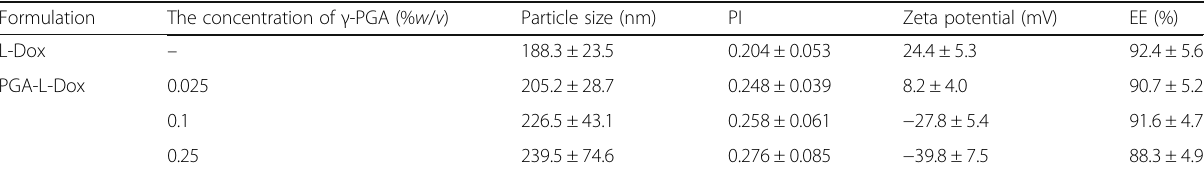
Table 1 Physicochemical properties of γ -PGA-coated Dox lipoplexes ( n = 3) Formulation